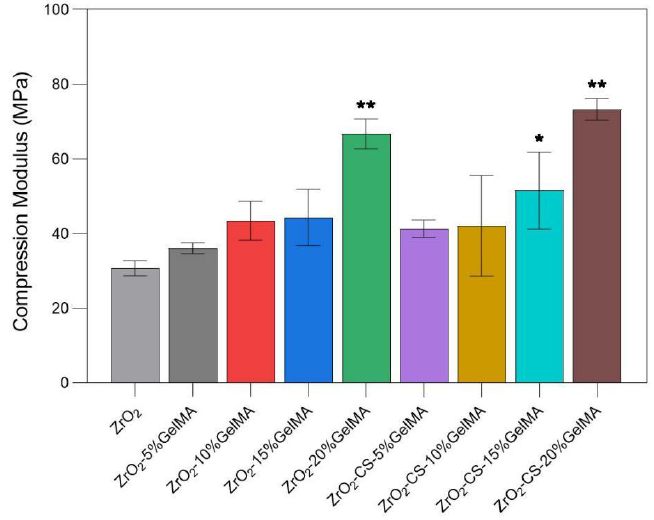
Figure 8. Compressive strength of porous zirconia scaffolds with composite scaffolds, * p < 0.05, ** p < 0.01, compared to ZrO 2 group.